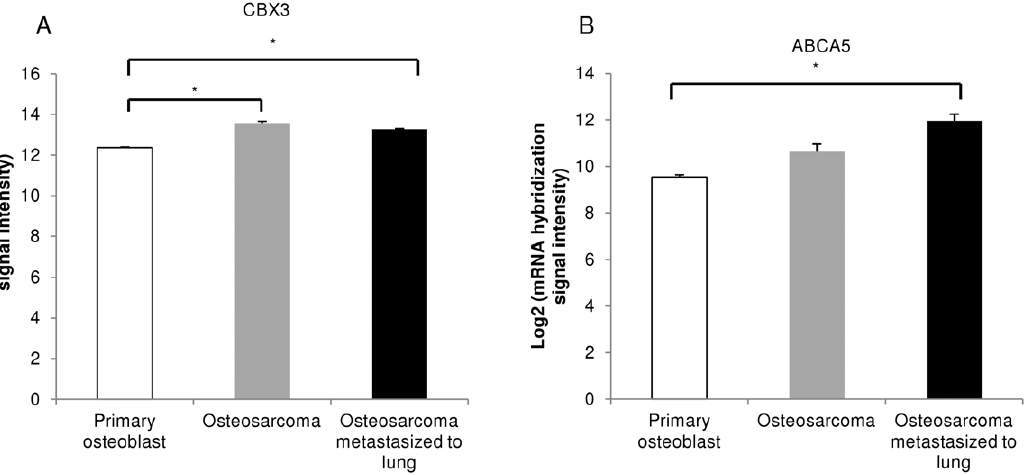
Figure 8. CBX3 and ABCA5 transcript expression in osteosarcoma biopsies. (A) CBX3 and (B) ABCA5 expression in osteosarcoma and osteosarcoma metastasized to lung biopsies as compared with primary osteoblasts, analyzed via microarray data available in GEO. *p , 0.05.